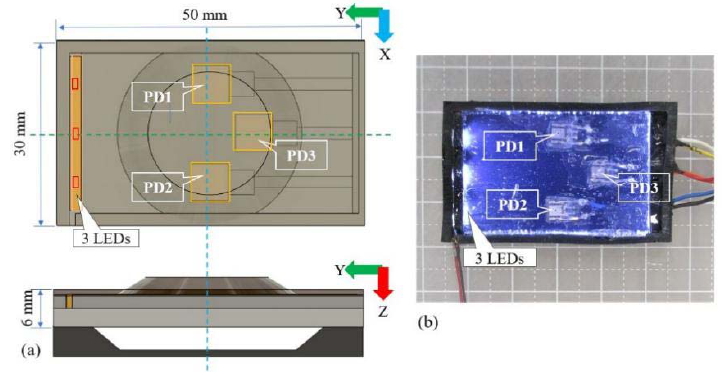
Figure 3. ( a ) Sensor structure, ( b ) photograph of top view, without top cover.